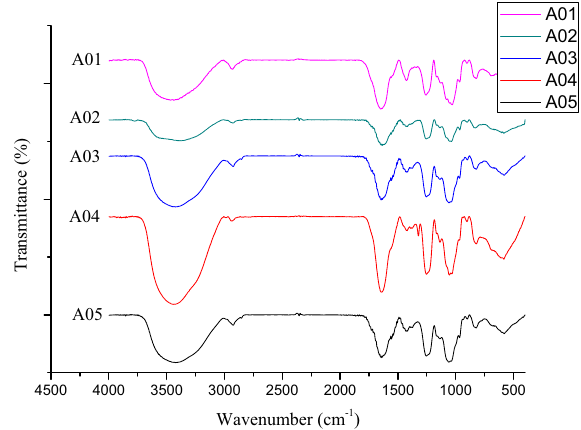
Figure 1. FT-IR spectra of fucoidan from different S. illicifolium locations.